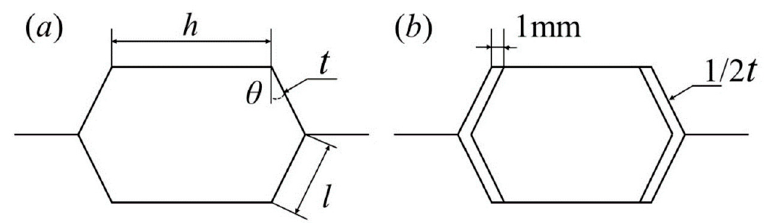
Figure 11. Convex honeycomb and dual-wall hexagonal honeycomb: ( a ) convex honeycomb; ( b ) dual-wall hexagonal honeycomb.